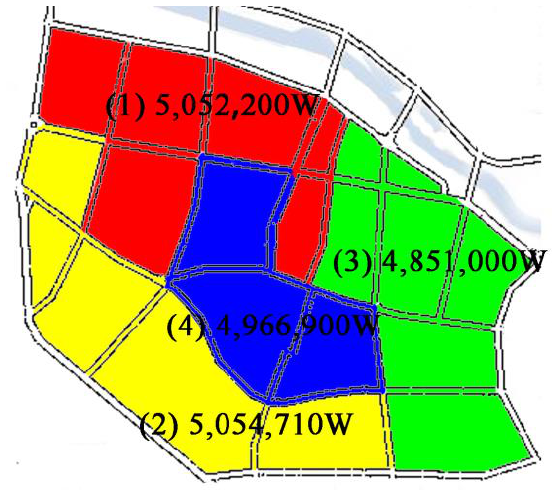
Figure 4. Schematic diagram of an integrated energy park.